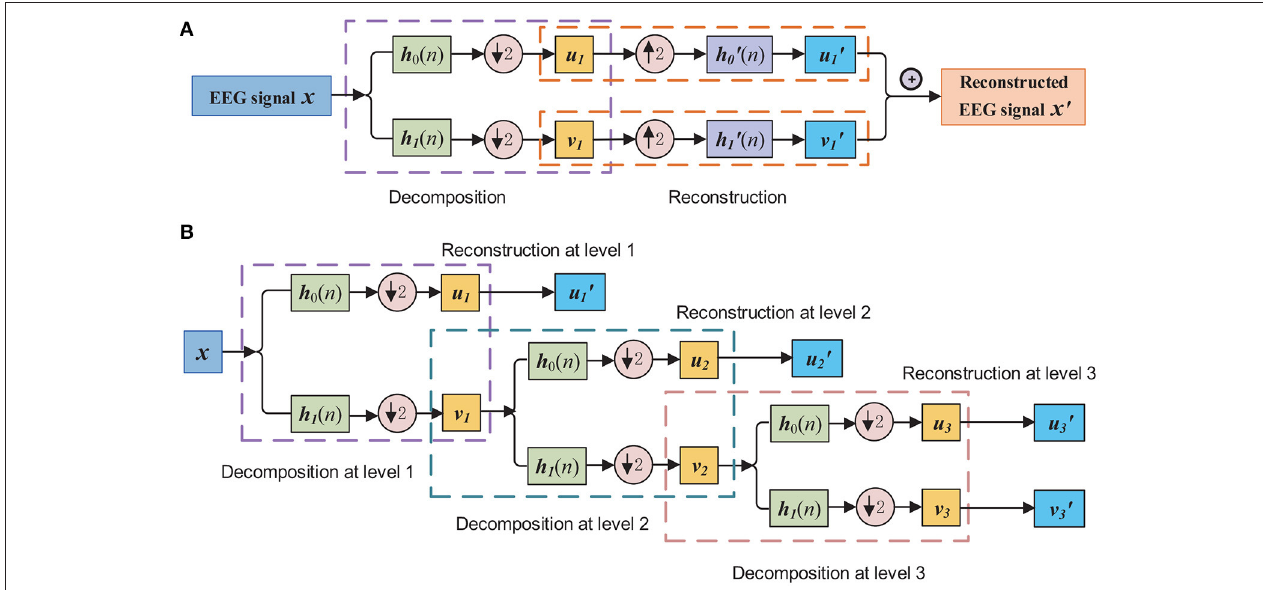
FIGURE 1 | (A) EEG signal decomposition and reconstruction by orthogonal wavelet. Here h 0 ( n ) and h 1 ( n ) present the finite impulse response of the half-band LP filter and half-band HP filter, and h ′ 0 ( n ) and h ′ 1 ( n ) present the reversed filters of h 0 ( n ) and h 1 ( n ), respectively. (B) EEG signal decomposition and reconstruction by orthogonal wavelet filtering to obtain the wavelet filtered and embedded EEG data, with the level of wavelet decomposition equals to three.